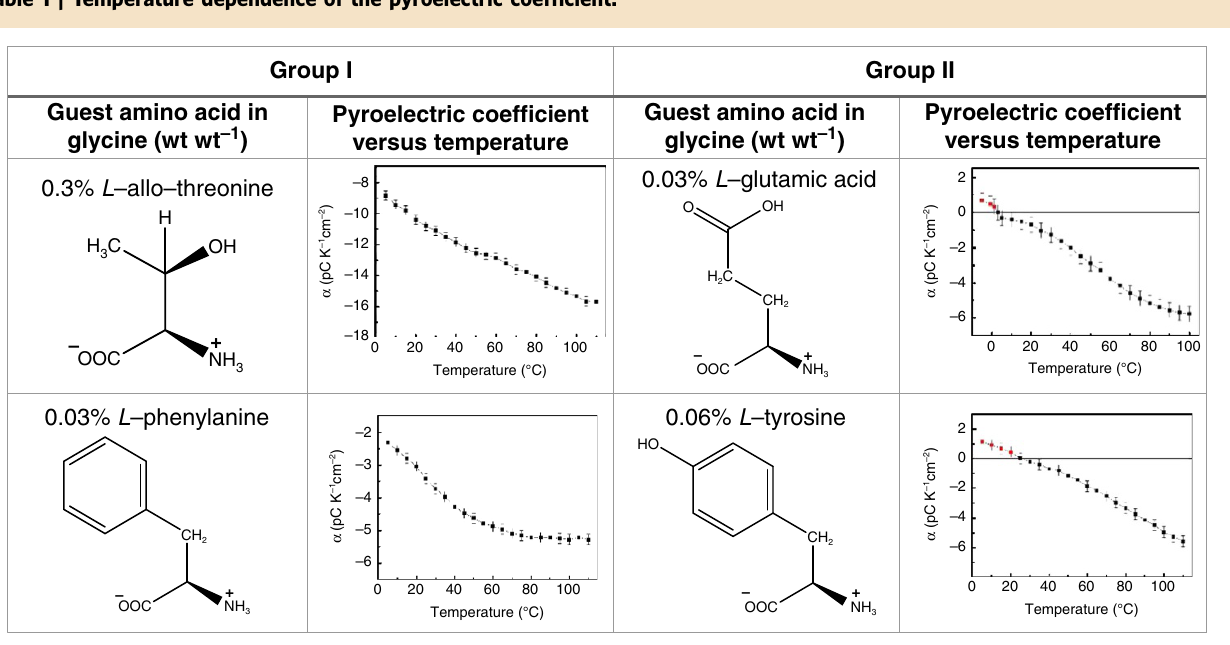
Group I: Pyroelectric coefficient does not change sign with temperature; Group II: Pyroelectric coefficient changes sign from positive to negative upon heating. The error bars show the s.d. of the pyroelectric coefficient at each temperature. Error bars represent s.e.m. values.